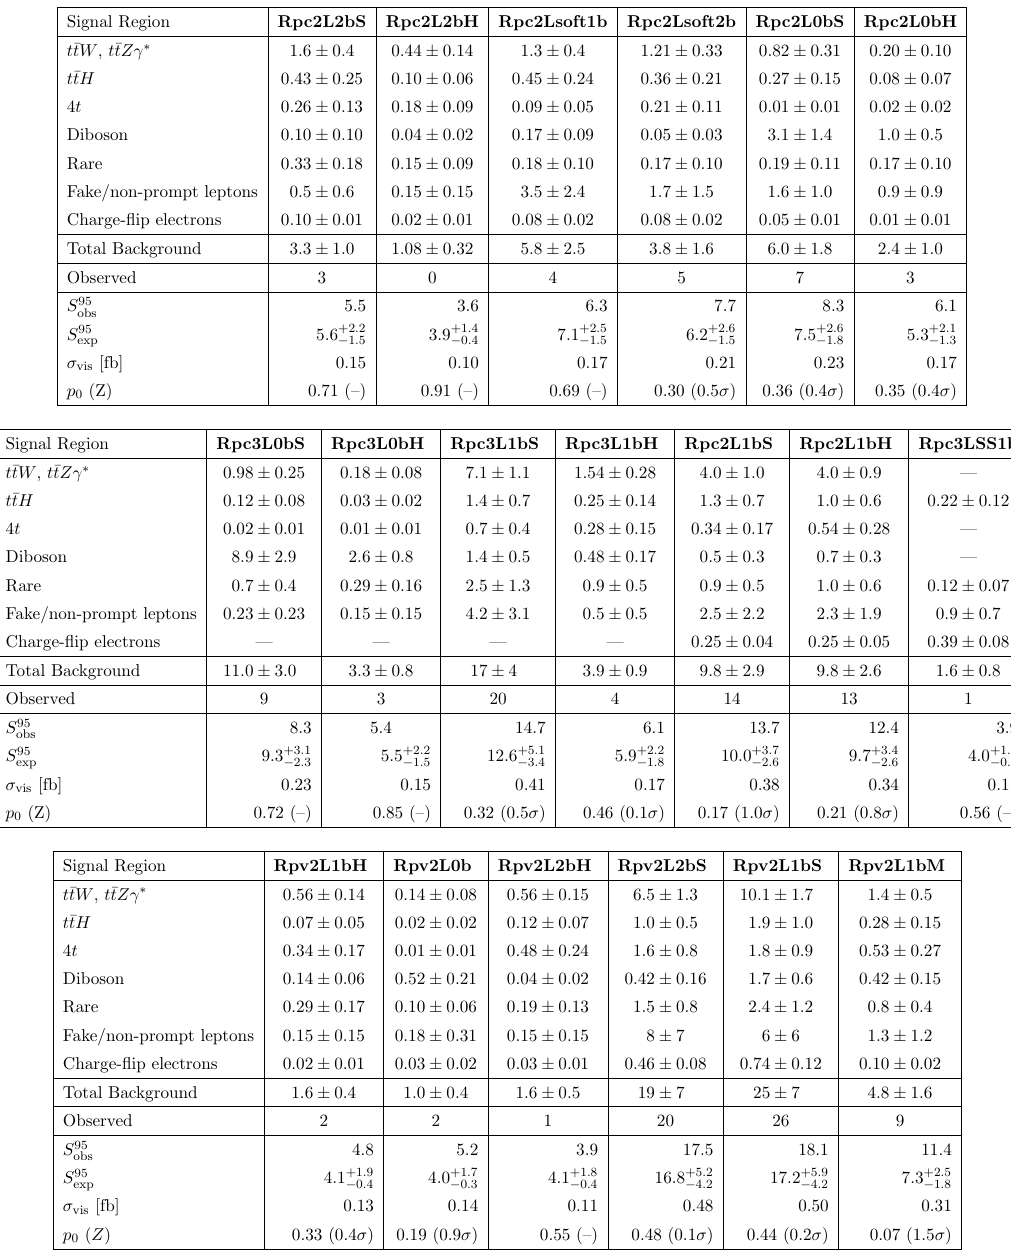
Table 5. Numbers of events observed in the signal regions compared with the expected back- grounds. The rare category is de(cid:12)ned in the text. Background categories with yields shown as a \{" do not contribute to a given region (e.g. charge (cid:13)ips in three-lepton regions) or their estimates are below 0.01. The 95% con(cid:12)dence level (CL) upper limits are shown on the observed and expected numbers of BSM events, S 95 and S 95 (as well as the (cid:6) 1 (cid:27) excursions from the expected limit), exp obs respectively. The 95% CL upper limits on the visible cross-section ( (cid:27) vis ) are also given. Finally, the p-values (p 0 ) give the probabilities to observe a deviation from the predicted background at least as large as that in the data. The number of equivalent Gaussian standard deviations ( Z ) is also shown when p 0 < 0 :